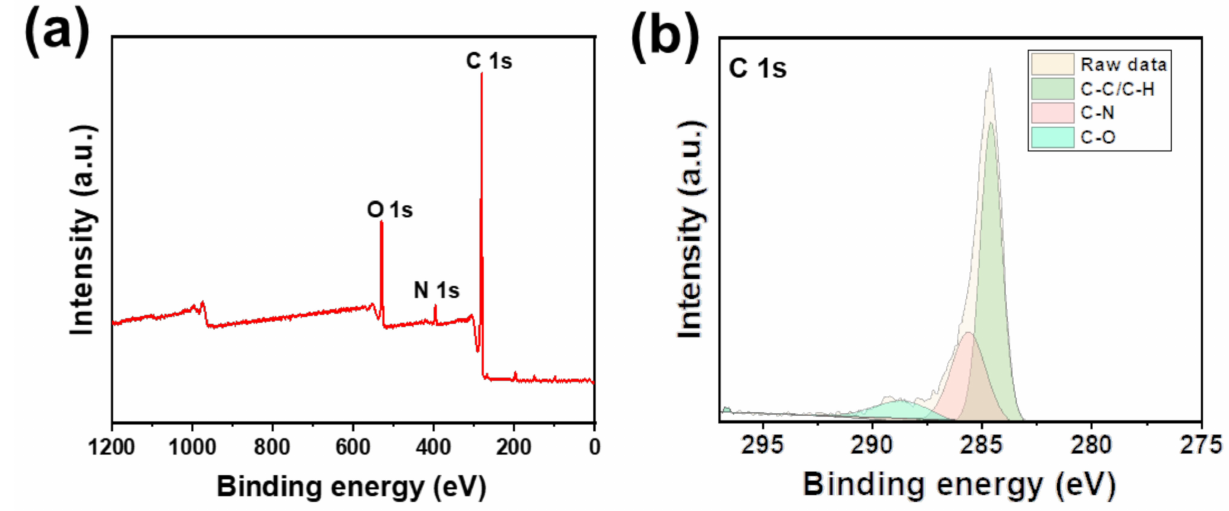
Figure 4. XPS spectra of CTF-DBF: ( a ) Wide-scan survey spectra; ( b ) High-resolution C